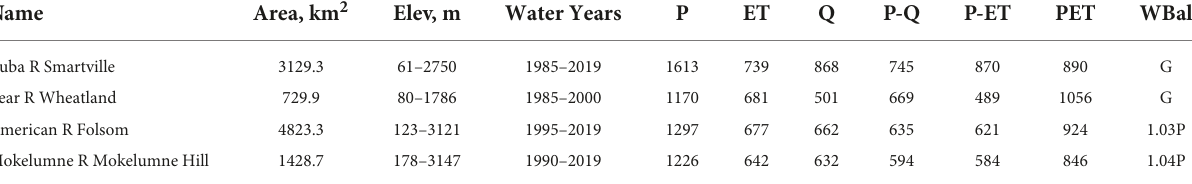
TABLE 2 Watersheds for which full natural flow data were